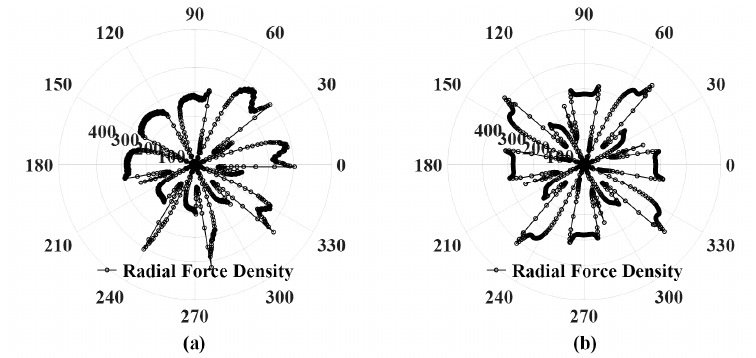
Figure 3. Comparison of the analysis results of permanent magnet machines with two different pole/slot combinations: ( a ) radial force density of 9-slots and ( b ) radial force density of 12-slots.